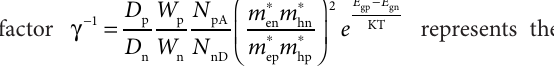
et al., 2010). As we shall see shortly, scaling of the injector with respect to the trapping layer reduces this recombination current ideally by the ratio of trapping layer to injector area ( A B / A E ). The factor γ −